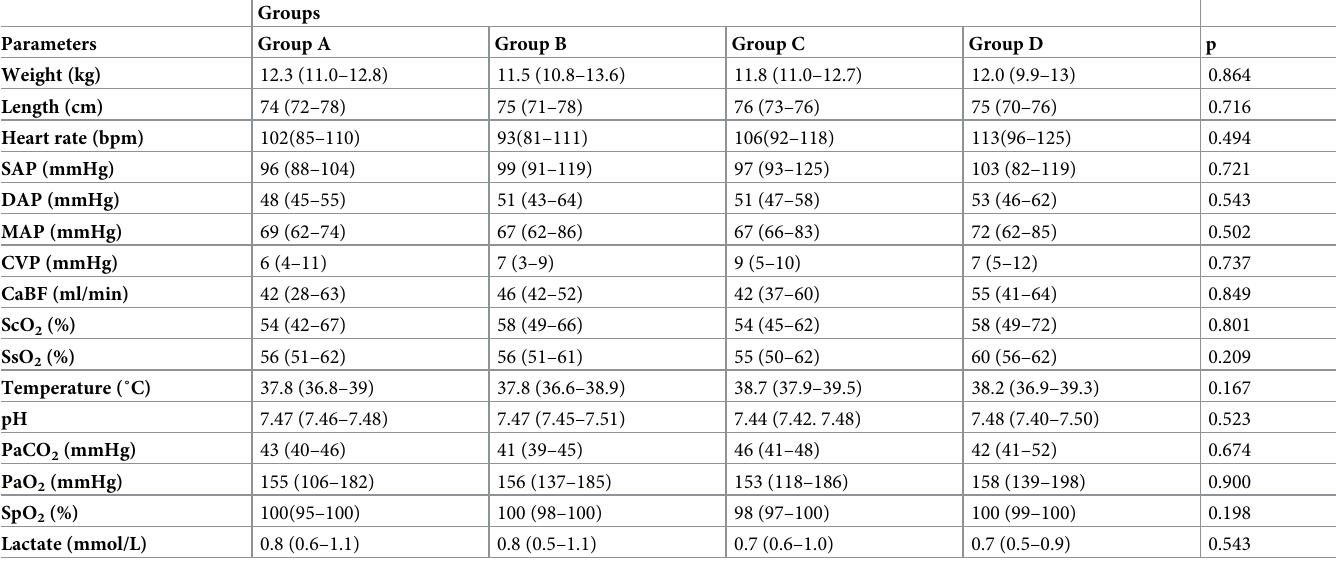
Table 1. Comparison of hemodynamic and respiratory parameters at baseline between groups (median and interquartile range).